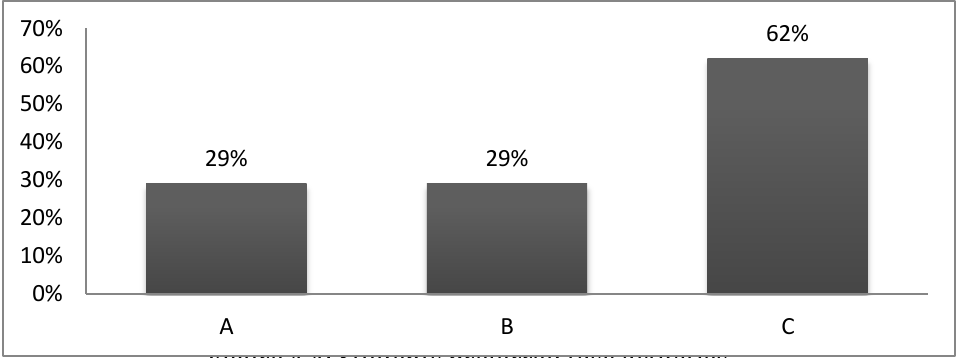
Figure 4.4 : Students ’ preferred task activities